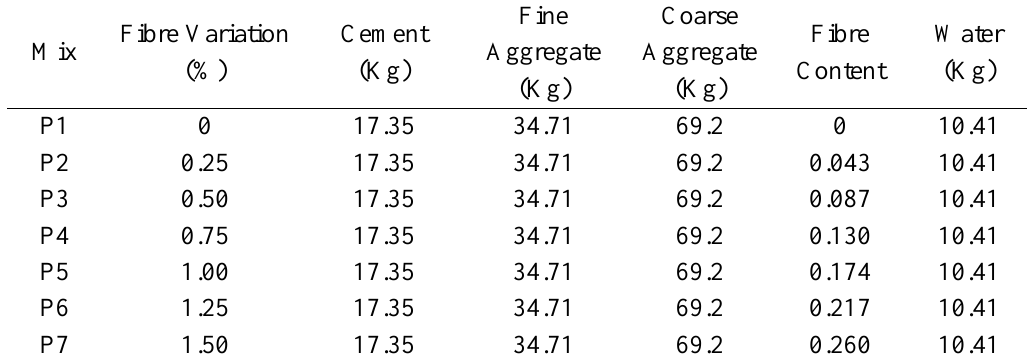
Table 1. Sample mix constituent and proportions